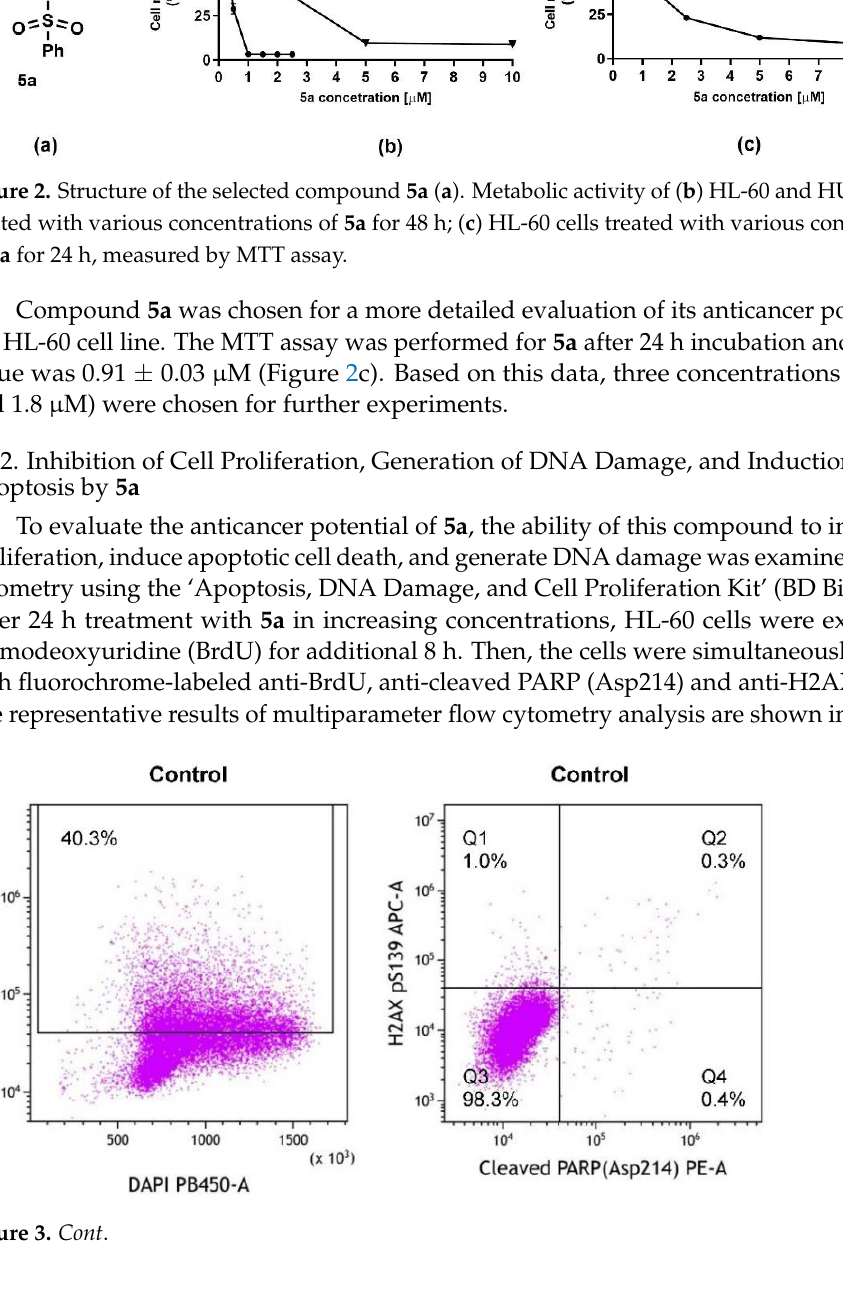
( b ) Figure 3. Representative scattered blots of multiparameter flow cytometry analysis of cell prolifer- ation, DNA damage and apoptosis in HL-60 cells treated with 5a (1.8µM) for 24 h. Panel ( a ): DAPI vs. BrdU PerCP-Cy.5.5 staining profile. BrdU positive cells are in the inside frame. Panel ( b ): cleaved PARP (Asp214) PE vs. H2AX (pS139) Alexa profile. Squares Q1 + Q2 represent H2AX (pS139) Alexa positive cells, squares Q2 + Q4 represent cleaved PARP (Asp214) PE positive cells, whereas square Q3 represents H2AX (pS139) Alexa and cleaved PARP (Asp214) PE negative cells. BrdU is an analog of thymidine, and its incorporation into DNA was used as an index of cell proliferation. 5a dose-dependently inhibited cell proliferation. At 1.8 µM concen- tration, this analog caused a 2.2-fold decrease in BrdU incorporation (Figure 4a). To check whether the cytotoxic effect of 5a was associated with the induction of apop- tosis, the pro-apoptotic activity of this compound was investigated. Apoptosis regulation is triggered by the activation of caspases [17]. Caspase-3, an effector caspase, cleaves a number of vital proteins, leading to cell death. The activity of caspase-3 was assessed by flow cytometry using fluorochrome-labeled antibodies recognizing 89 kDa-cleaved PARP fragments released from PARP by caspase-3 in the executive stage of apoptosis. Incuba- tion of HL-60 cells with 10a (at 1.35 and 1.8 µM) for 24 h led to a significant increase in the